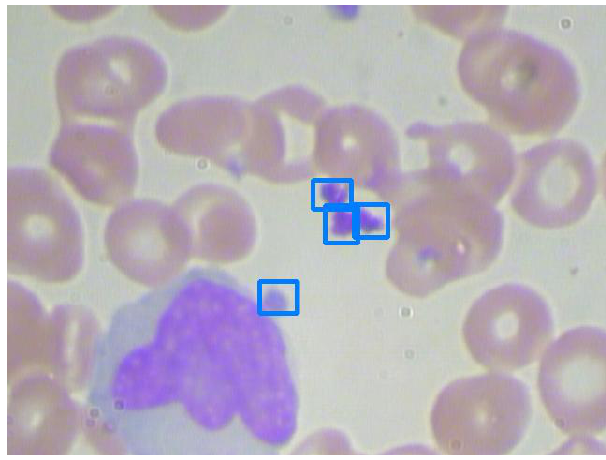
Figure 11. An image with clustered platelets. Table 8. Comparison of the experiment results between Figure 10, Figure 11, and validation set. Confidence Score: 0.9